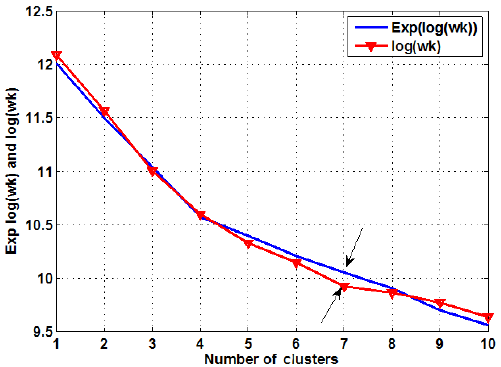
Figure 9. Lifespans of homogenous wireless sensor nodes: (red) LEACH algorithm; (blue) combination of clustering